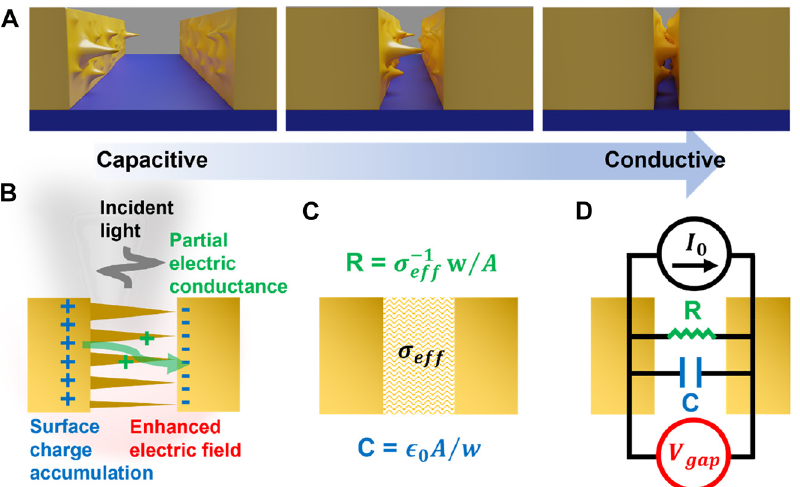
Figure 8: Zero-nanometer limit for an extended gap. (A)Aschematicviewofanextendedmetallicnanogapreachingasubnanometerwidthandbelow.Thegapdoesnotcloseuniformly,andthere always exist salient pyramids that make point contacts fi rst. The gap therefore gradually transitions from capacitive to conductive screening regime. (B) Description of an extended gap in a partially conducting regime. Incident light creates surface current which in turn accumulate charges at the surface and induce the electric fi eld enhancement. The capacitive charge accumulation is partially screened by conduction of electric current through the pyramids. (C) Effective medium description of the gap depicted in (B). Permittivity of the gap ϵ gap is related to σ eff via Eq. (14) in the main text. (D) R – C circuit representation of the gap, where each component is drawn in the same color as the corresponding phenomenonin (B). Response of the circuit can be described as V gap ( f ) = I 0 ( f ) / ( R − 1 − i 2 π fC ) , which allow us to express the effective optical permittivity of the gap as ε gap = 1 + i / 2 π fRC